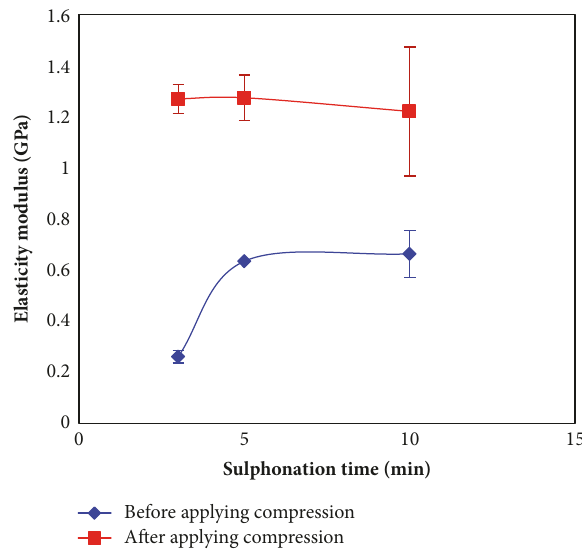
Figure7:Theeffectofcompressionontheelasticmodulusofatreat- ed layer with different sulphonation times.